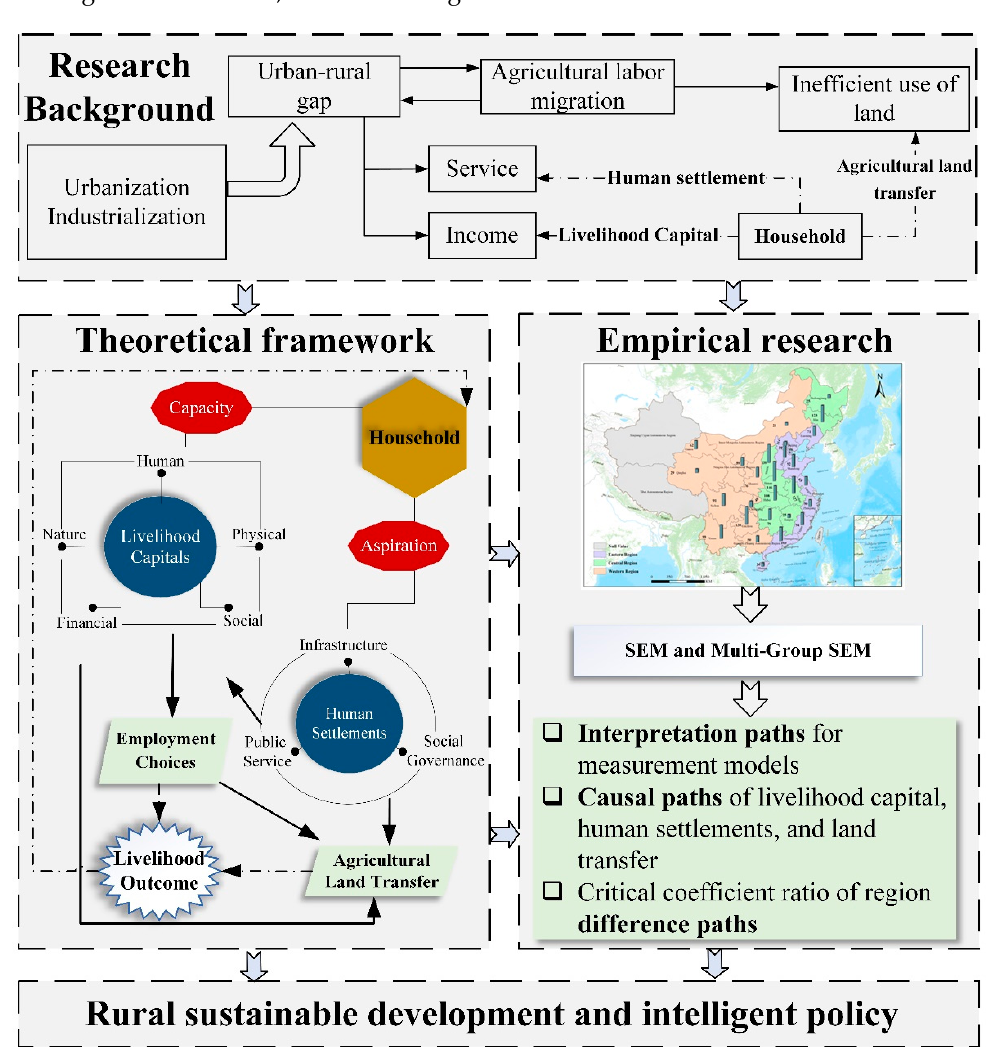
Figure 1. Agricultural land transfer decision-making process.